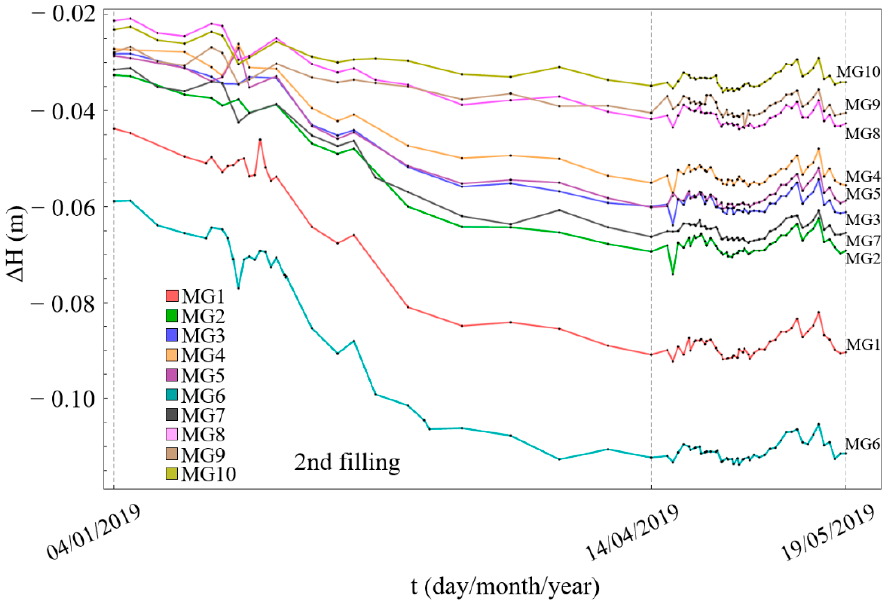
Figure 6. Settlement visualization of points MG1 to M10, from 04/01/2019 to 19/05/2019. Points MG19 to MG21 were monitored during second filling from 02/02/2019 to 14/04/2019, as well as some time after the last measurements on 19/05/2019 (Figure 8). While points DRMG19a, DRMG20a and SSP1 to SSP6 were monitored from roughly the same initial time (04/02/2019, 06/02/2019), monitoring ended on 21/03/2018 (Figures 9 and 10).